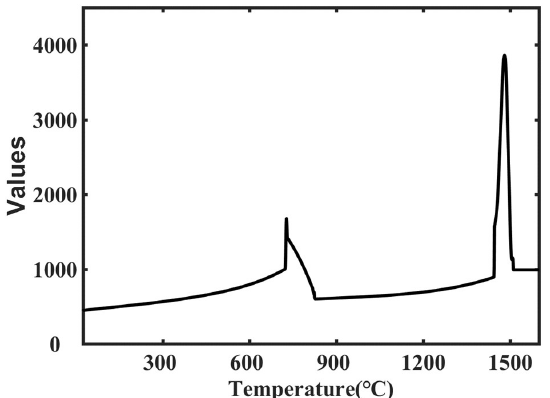
Figure 2. Temperature-dependent density and heat conductivity coefficient of 1700MS, data from ref. [17].